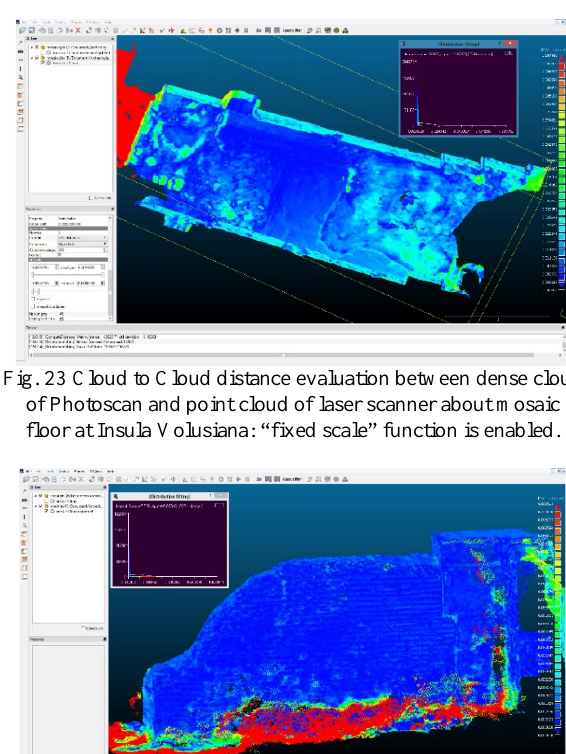
Fig. 22 Cloud to Cloud distance evaluation between dense cloud of Photoscan and point cloud of laser scanner about mosaic floor at Insula Volusiana: “fixed scale” function is disabled. The minimum distance set at 0.000019 cm is represented with blue color while the maximum set at 0.10 cm with red (this area doesn’t exist in point cloud). The “approximate mean distance” calculated by software was 0.05 cm, the “approximate minimal distance” 0.0038 cm, the sigma value was 0.167 cm. Main area for archaeological documentation was mosaic colored in blue. In a second comparison, using the “fixed scale” function in the alignment process is not possible to realize good results as the previous ones (fig. 23). The approximate mean distance calculated by software was 0.052 cm, the approximate minimal distance 0.0037 cm, the sigma 0.162 cm: in this case the mosaic’s area is colored with a gradient from blue to light blue in which the distance is more than 0.02 cm.